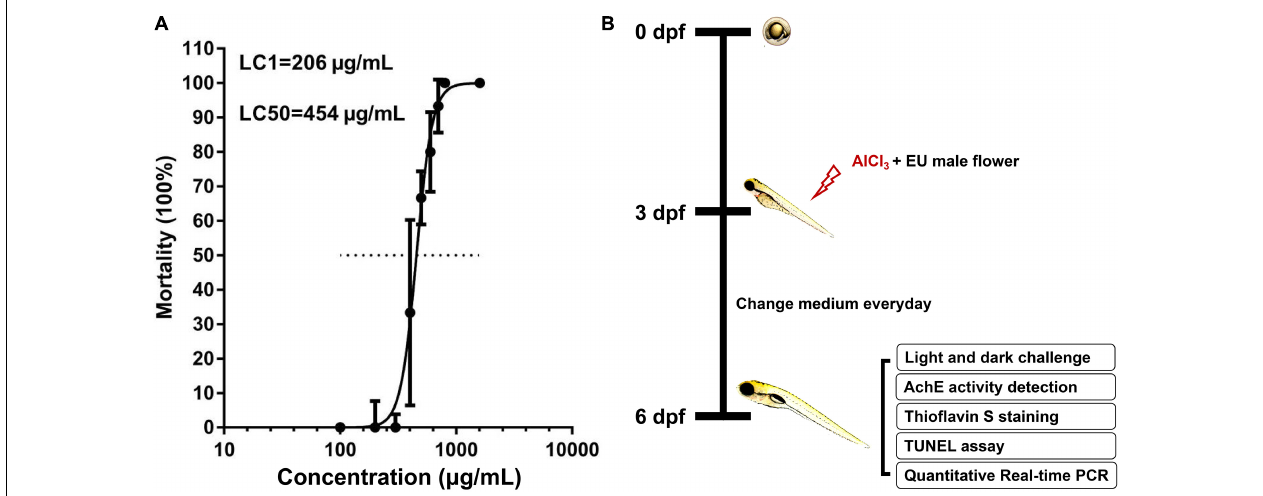
FIGURE 1 | Mortality curve and experimental workflow chart. (A) Larval zebrafish were exposed to different concentrations of EUMF (100, 200, 300, 400, 500, 600, 700, 800, and 1,600 µ g/mL) from 3 to 6 dpf. The mortality was recorded within each group at 3, 4, 5, and 6 dpf. Dead larvae were judged using missing heartbeats. (B) Larvae at 3 dpf were co-exposed to AlCl 3 and three different concentrations of EUMF from 3 to 6 dpf. At 6 dpf the zebrafish were subjected to a behavioral test. In addition, we also evaluated the AchE activity, A β deposition, and apoptosis in the brain and performed RT-qPCR.